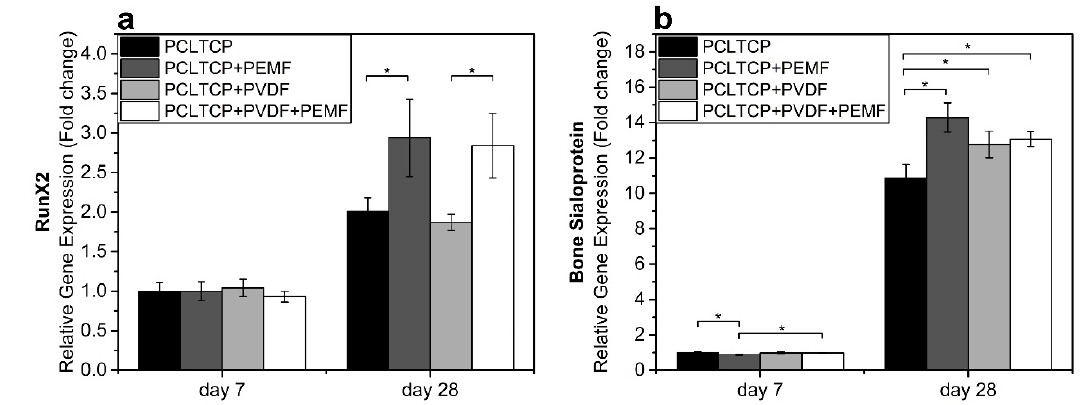
Figure 5. Osteogenic gene expression of early differentiation markers ( a ) RUNX2 and ( b ) bone sialoprotein ( BSP ) and late bone differentiation markers ( c ) osteocalcin ( OC ) and ( d ) osteopontin ( OP ). Sample groups: PCL-TCP without (PCL-TCP) and with PEMF (PCL-TCP+PEMF), PVDF-coated PCL-TCP without (PCL-TCP+PVDF) and with PEMF (PCL- TCP+PVDF+PEMF) (* p < 0.05, n = 3). The effect of PEMF and PVDF coating on osteogenesis is summarized in Table 1. Compared with the control group of pristine PCL-TCP scaffold, PEMF, as a single stimu- lus, positively impacts cell metabolic activity, cell proliferation, and osteogenic gene ex- pression, whereas PVDF coating, as a single stimulus, mainly enhances cell mineralization and osteogenic gene expression. The combination of both stimuli leads to better perfor- mance than using any single stimuli, with the proliferation and expression of late osteo- genic gene OC and OP most significantly boosted. The results in our study provide evi- dence that PEMF and PVDF could synergistically enhance osteogenesis of MC3T3-E1 cells in various aspects, including metabolic activity, proliferation, mineralization, and osteo- genic gene expression, potentially leading to more efficacious bone regeneration. Table 1. Summary of the effect of PEMF and PVDF coating on osteogenesis of MC3T3-E1 cells as compared with the control group of PCL-TCP